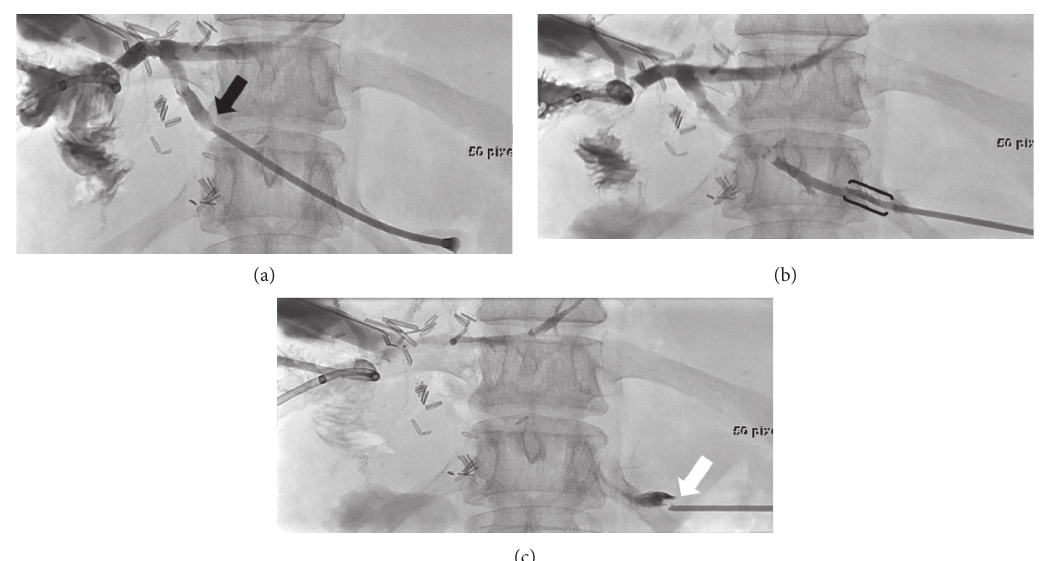
Figure 1: Case example with fluoroscopy images of a patient with hemihepatectomy for cholangiocellular carcinoma who received PTTE with gelatin foam after percutaneous transhepatic balloon dilation of a stenosis of the hepaticojejunal anastomosis (Department of Di- agnostic and Interventional Radiology of University Hospital of Heidelberg). (a) The 6 F-sheath is withdrawn from a dilated biliary duct (black arrow) by continuous injection of a contrast agent. (b) Injection of gelatin foam through a side port of the sheath into the transhepatic tract (black brackets). (c) Detachment of gelfoam (white arrow) from the sheath tip marks the liver